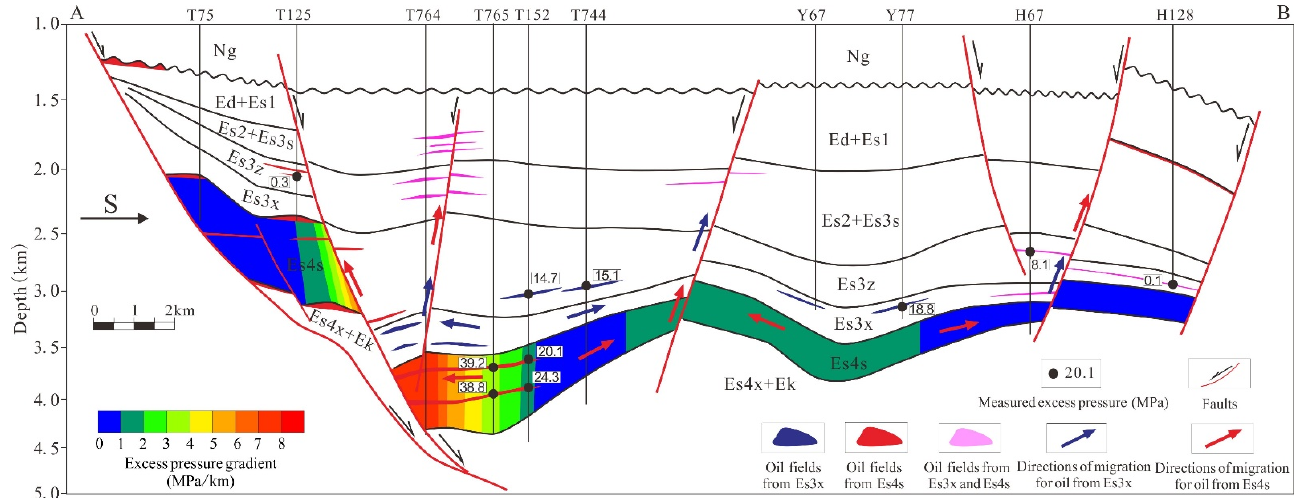
Figure 11. Profile of excess pressure and oil reservoir in Dongying Depression (The location of the A–B profile is shown in Figure